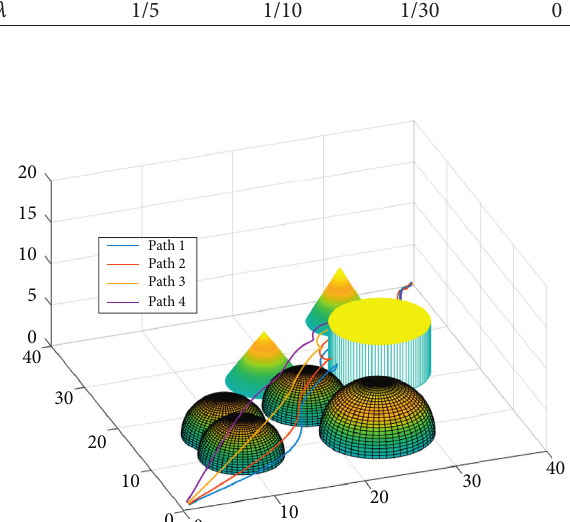
Figure 4: The planned path according to different saturation λ .